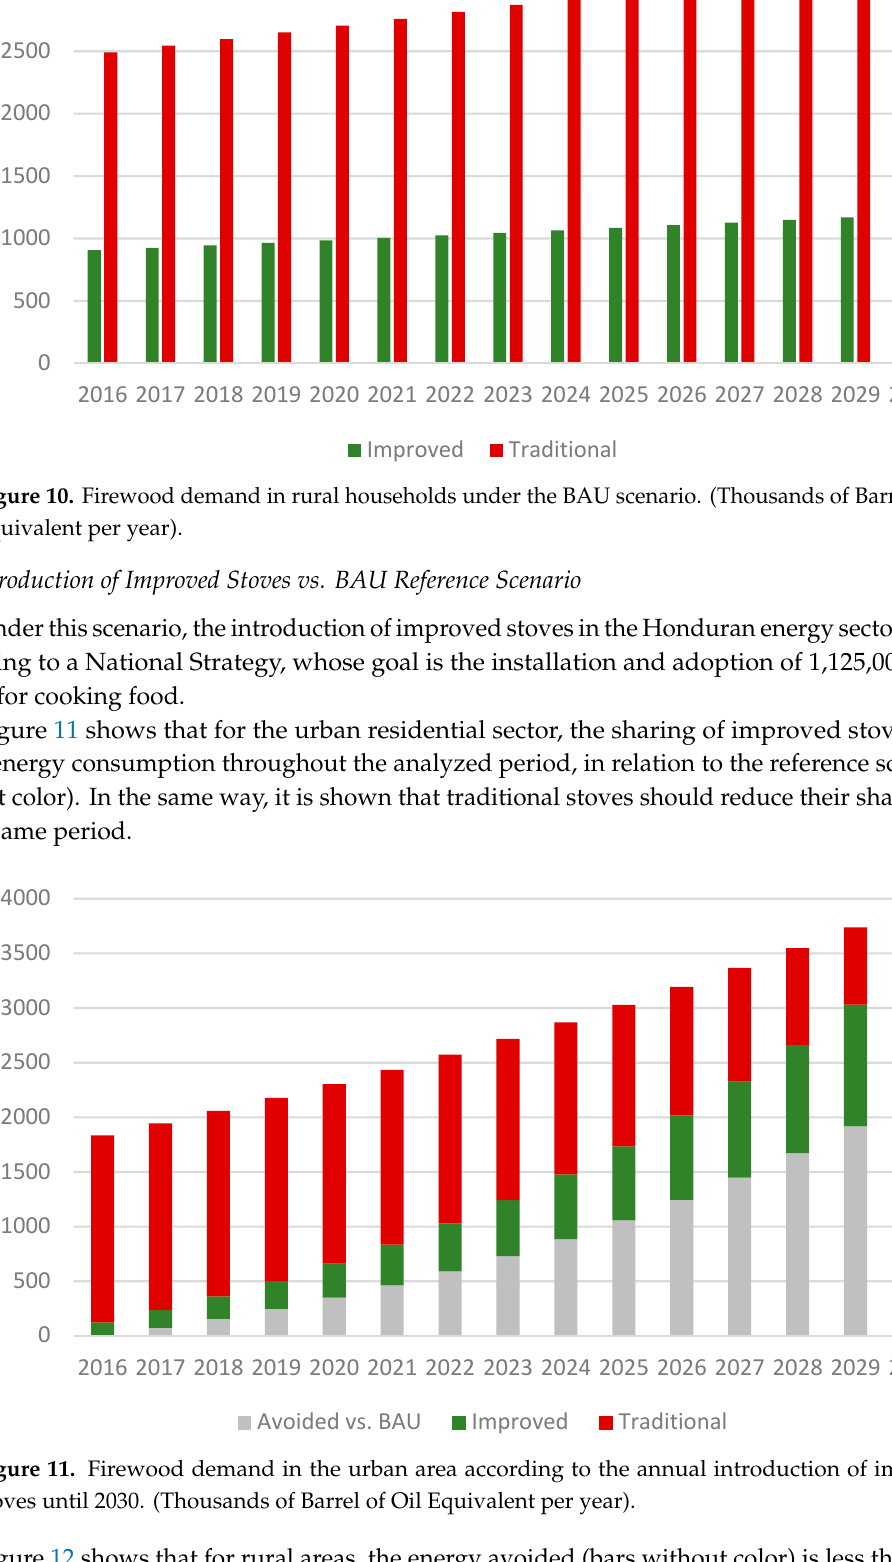
Figure 9. Firewood demand in urban households under the BAU scenario. (Thousands of Barrel of Oil Equivalent per year).